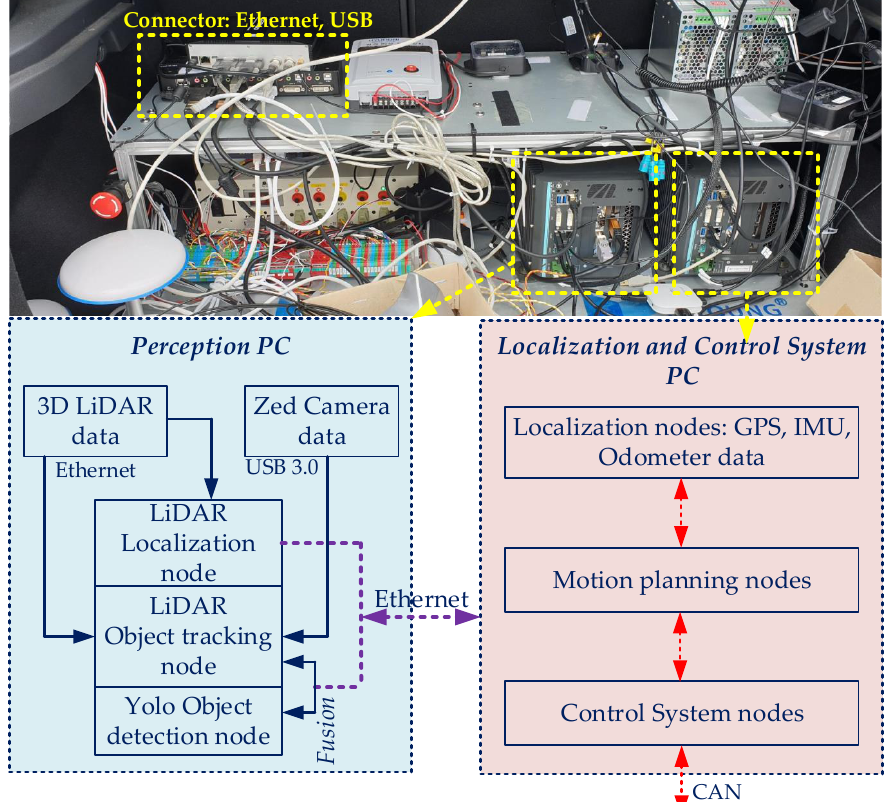
Figure 10. Software and hardware architecture. The left computer manages the perception using a stereo camera and 3D LiDAR fusion. The right computer performs the localization with multiple sensor fusion of GPS and IMU and the control system. The software architecture in Robot Operating System (ROS) middle-ware arrangement is joined between the two